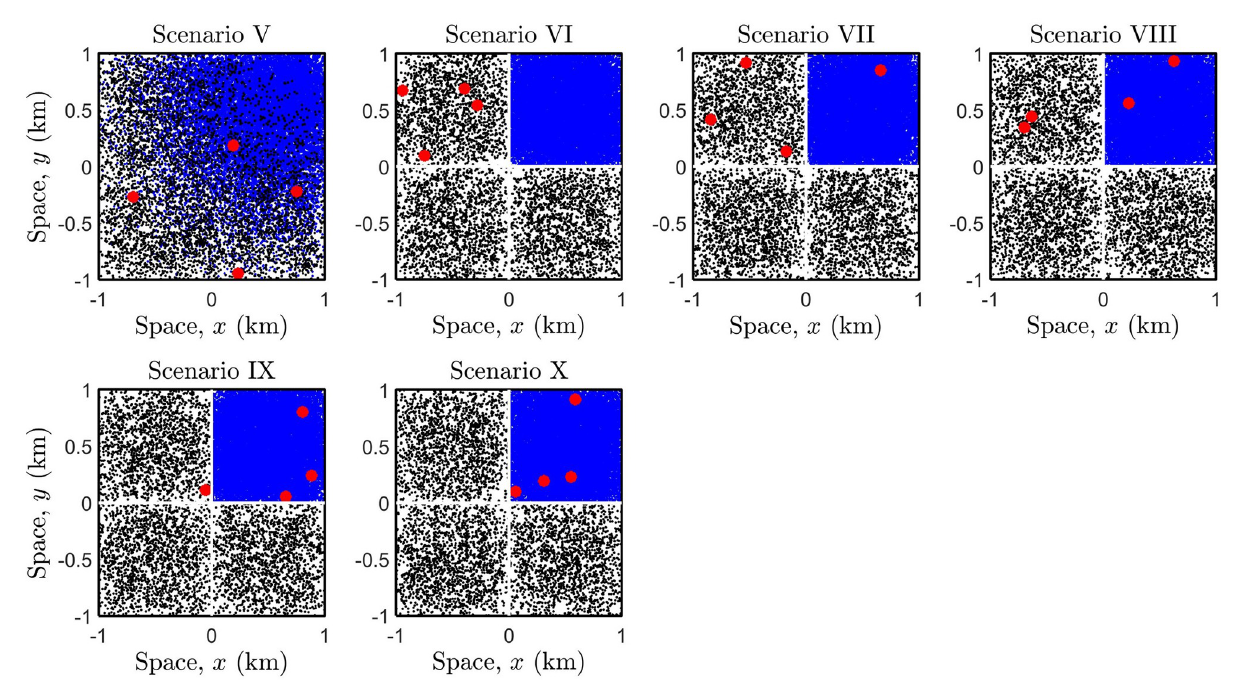
Fig 6. Lockdown scenarios in the case of a heterogeneous population spatial distribution.